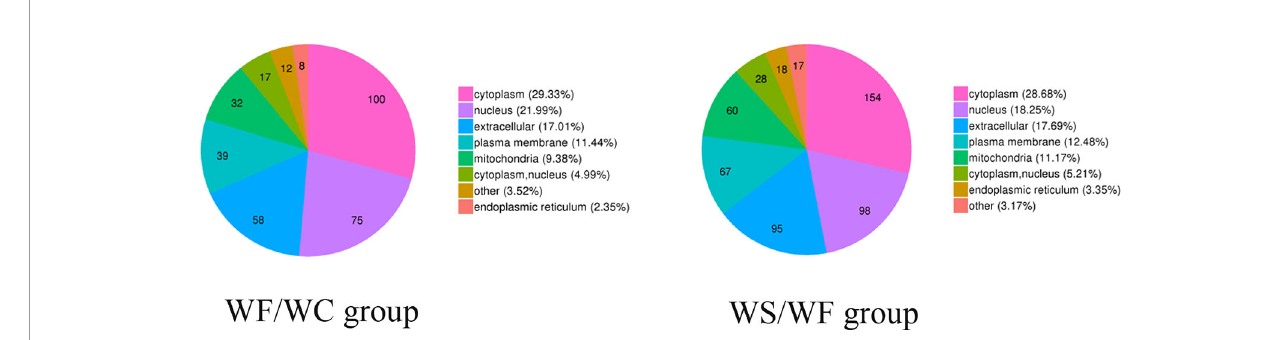
FIGURE 5 | Subcellular localization chart of differentially expressed proteins. The differential proteins in the two comparison groups are roughly distributed, mainly in the cytoplasm, nucleus, extracellular matrix, cell membrane, mitochondria, and endoplasmic reticulum.